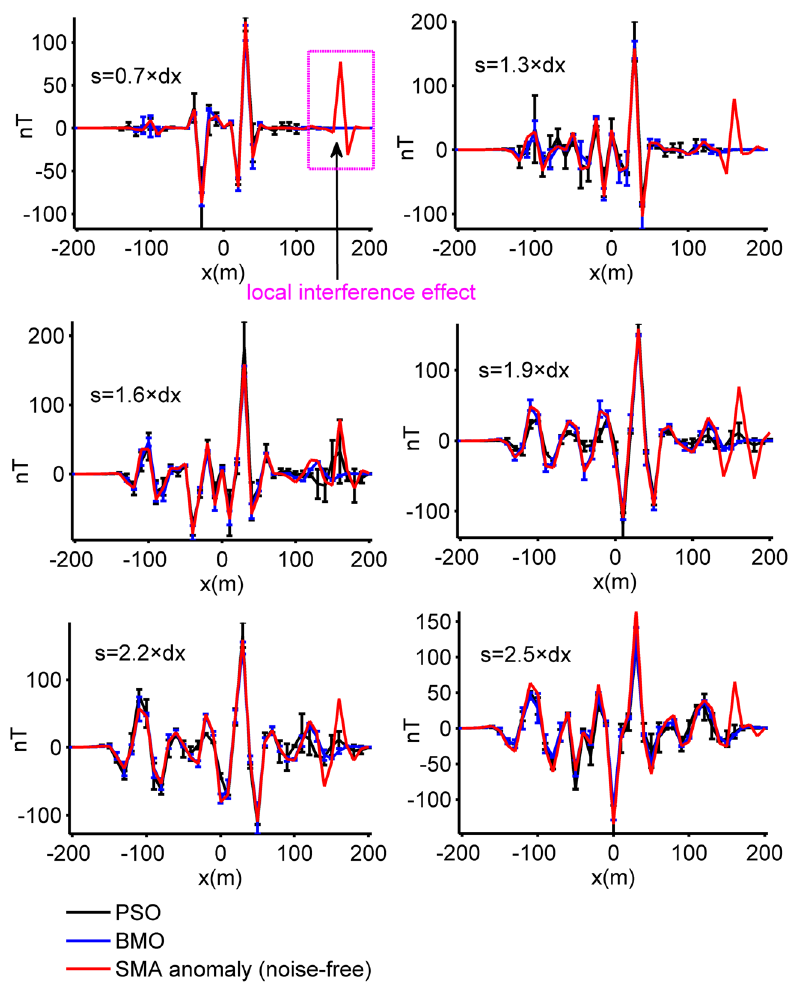
Figure 9. The calculated SMA magnetic anomalies of case 2 and estimated SMA magnetic responses using BMO and sPSO for different s values (0.7, 1.3, 1.6, 1.9, 2.2, and 2.5 × dx, dx = 10